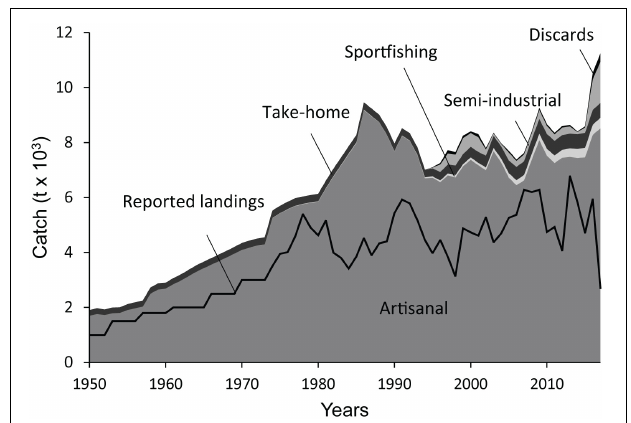
FIGURE 2 | Total reconstructed domestic catch for Seychelles from 1950 to 2017 within Seychelles’ EEZ by fishing sector. Landings as reported by FAO on behalf of the Seychelles are represented as the black overlay line. Industrial large-scale tuna and billfish fisheries are excluded and addressed separately in the global spatial tuna database (Coulter et al.,